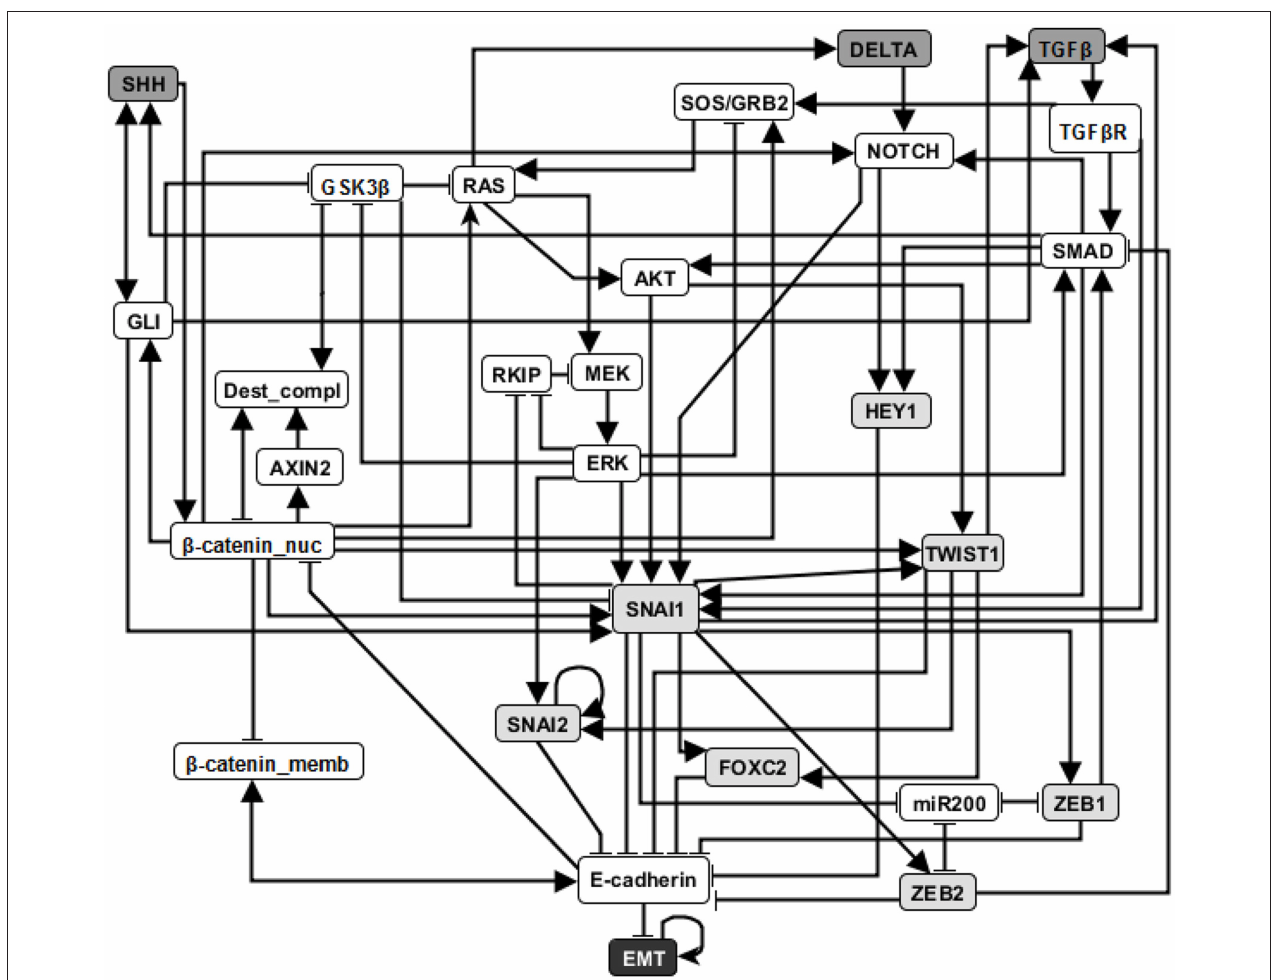
FIGURE 3 | An illustration of the EMT network. Attractor-preserving network reduction (Saadatpour et al., 2013) was applied to better focus attention on the most relevant nodes. Specifically, source nodes that represent input signals that are absent in the studied context are removed and each node with one input or one output is absorbed into its input or output, respectively. Nodes with light gray background are direct regulators of E-cadherin and nodes with dark gray background represent external signaling molecules. Edges ending with an arrow represent positive regulation while edges end with a flat bar represent negative regulation. See more details in Supplementary Material section